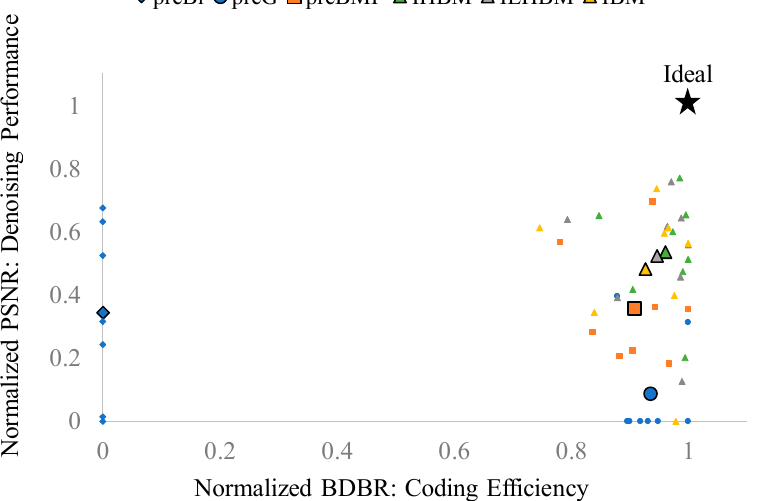
Figure 4. Compression–Denoising Performance.